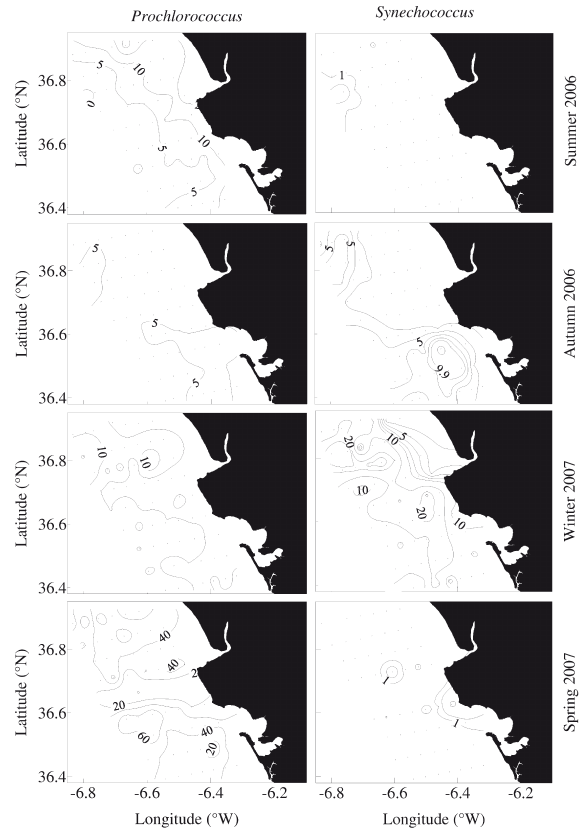
f ig . 4. – Horizontal distributions of Prochlorococcus (10 3 cell mL –1 ) and Synechococcus (10 3 cell mL –1 ) in the Gulf of Cádiz dur- ing the summer, autumn, winter and spring